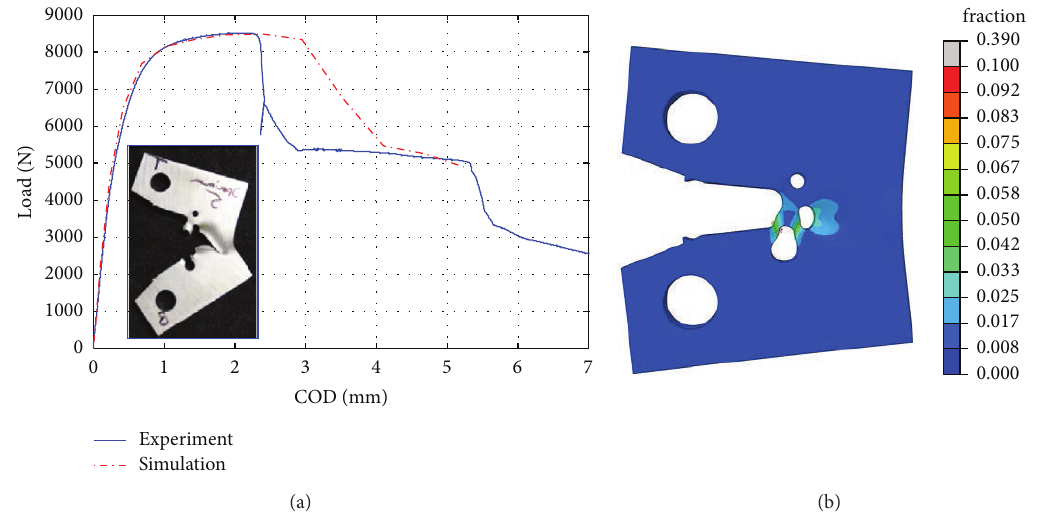
Figure 6: Experimental and simulated load versus COD profiles for S5 specimen, (a). The contour of void volume fraction, showing void accumulation along ligaments A-D and D-C, taken at load = 5,474 N, (b). Photograph of specimen adapted from [4].